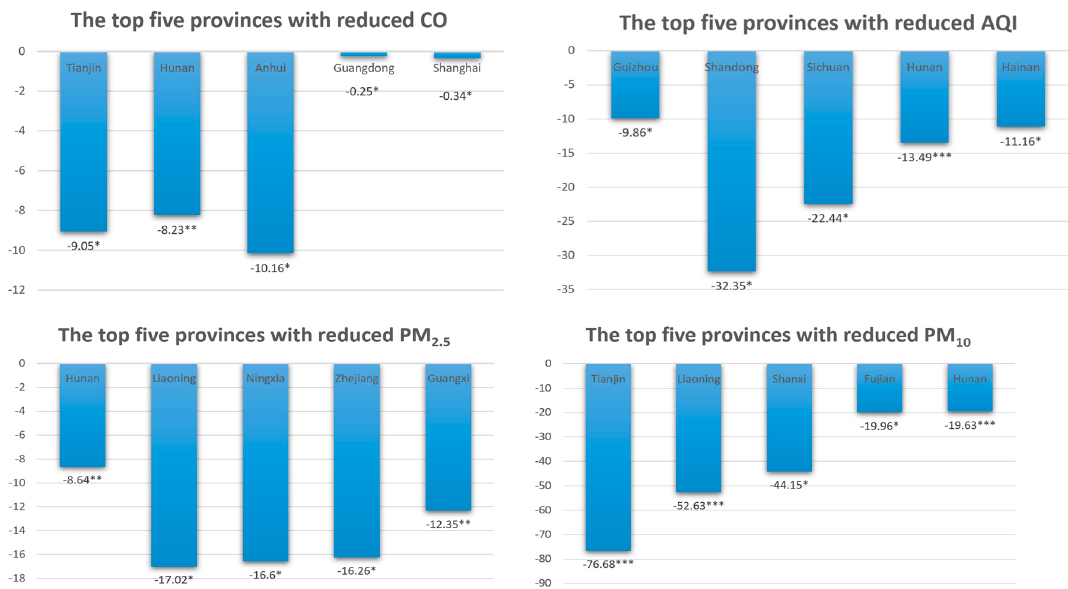
Figure 5. Ranking of pollutant reduction in each province.